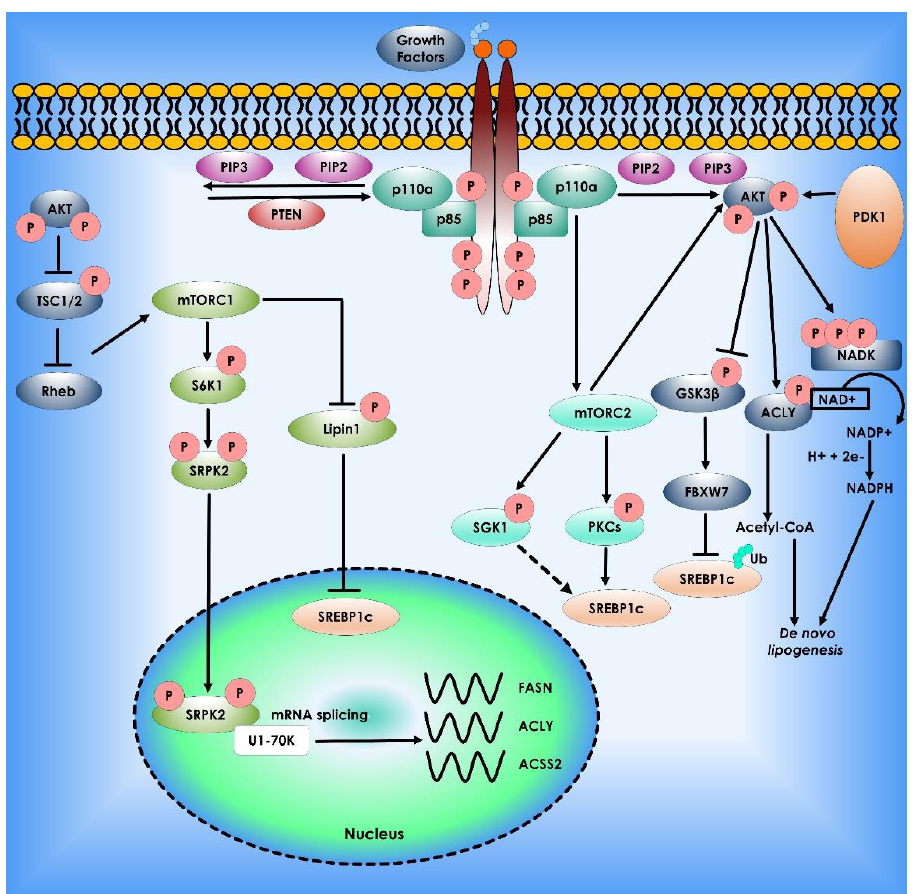
Figure 3. Akt mTOR signaling Pathway in Lipid Synthesis. The phosphatidylinositol-3-kinase (PI3K)/Akt and the mammalian target of rapamycin (mTOR) signaling regulate lipid metabolism. The most often dysregulated mechanism in cancer is PI3K signaling, which promotes growth, proliferation, and survival. When receptor tyrosine kinases are activated, PI3K is recruited to the plasma membrane and phosphorylates Phosphatidylinositol 4,5-bisphosphate (PIP2) to Phosphatidylinositol (3,4,5)- trisphosphate (PIP3). AKT binds to PIP3, allowing PDK1 and mTORC2 to activate. AKT stimulates lipogenesis directly by inhibiting Glycogen synthase kinase 3, activating ATP citrate lyase to make acetyl-CoA, and phosphorylating NADK to produce NADP+ for NADPH production. PI3K